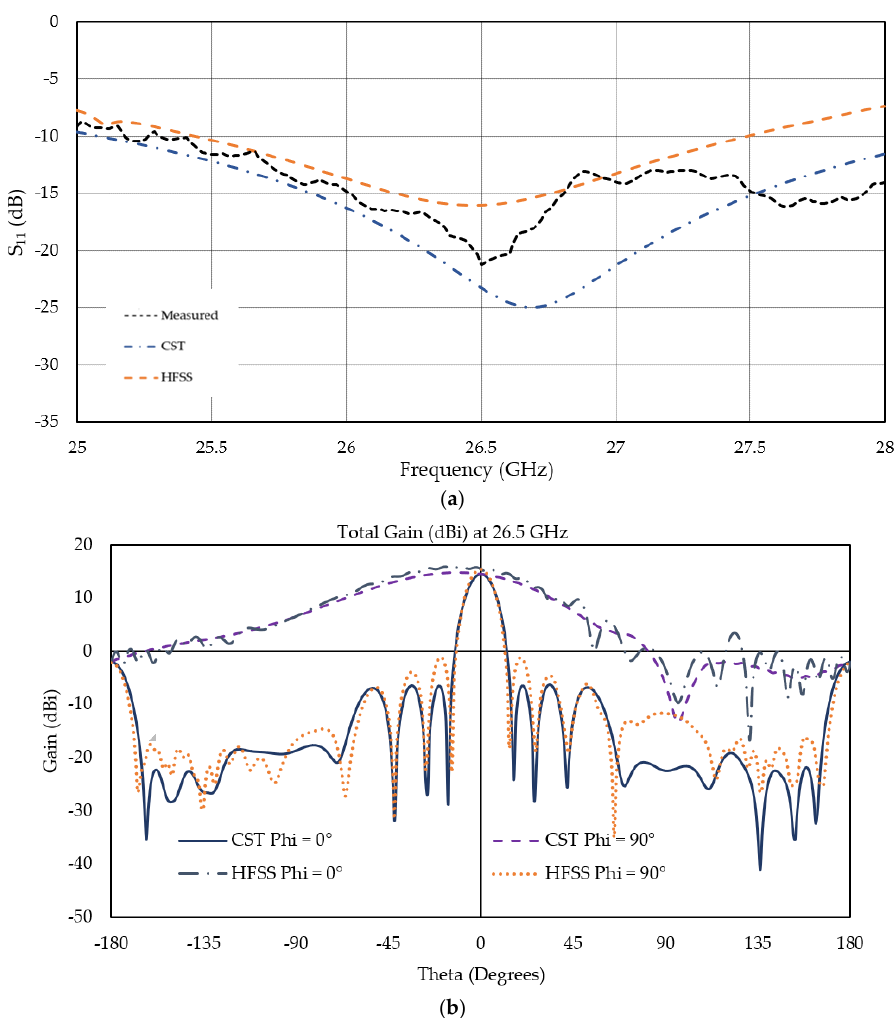
Figure 6. ( a ) S 11 comparison among CST, HFSS, and measured values and ( b ) gain comparison obtained from CST and HFSS at 26.5 GHz.